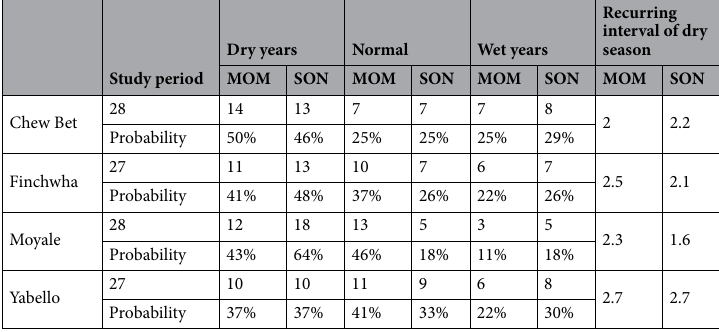
Table 8. Occurrence of dry seasons and dry-season intervals based on the RAI (1990–2017).